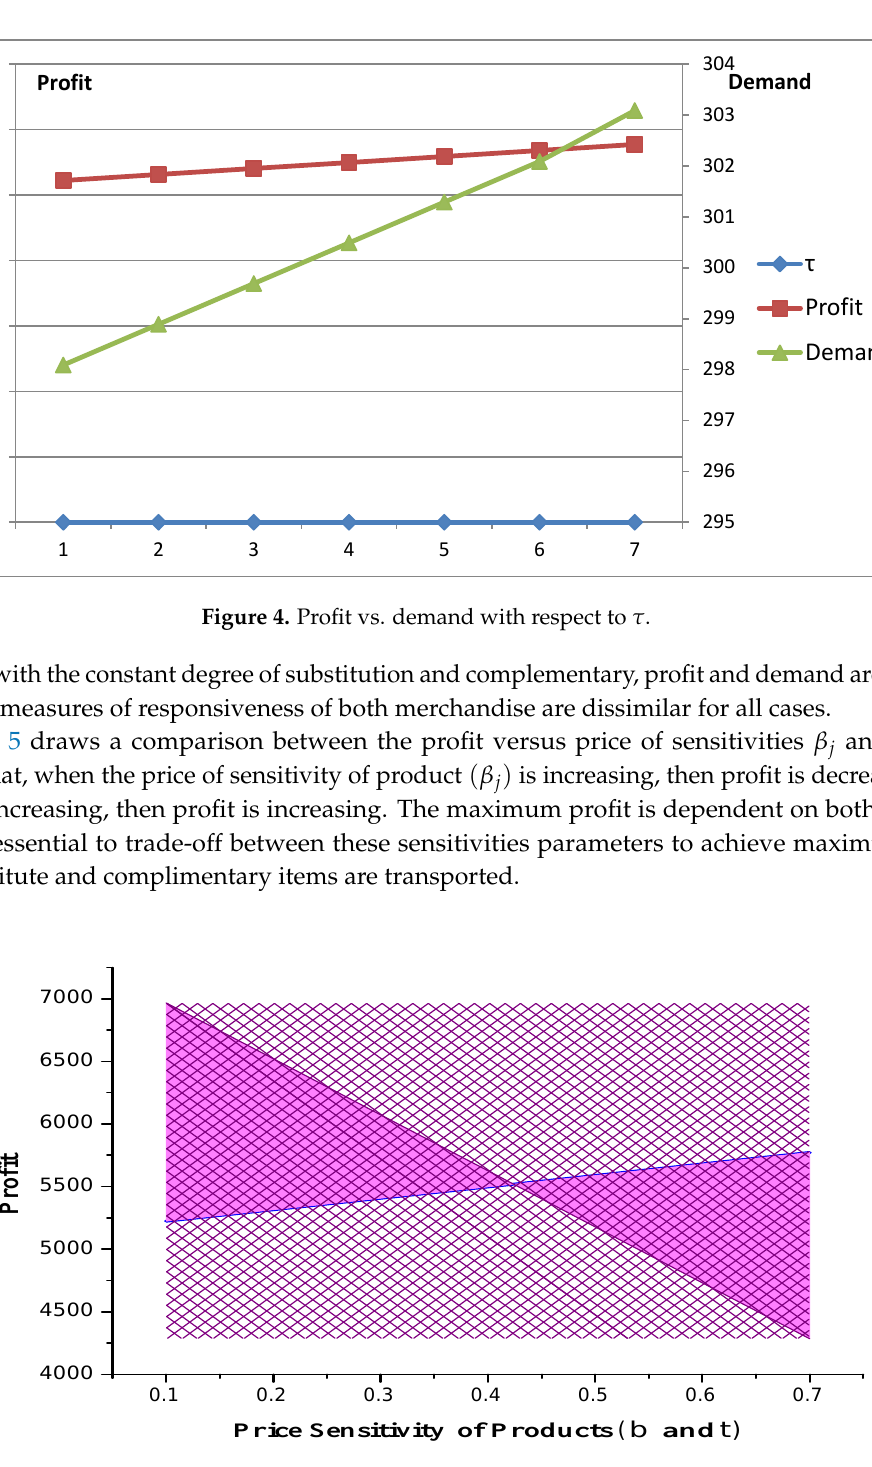
Figure 5. Profit vs. demand with respect to β and τ